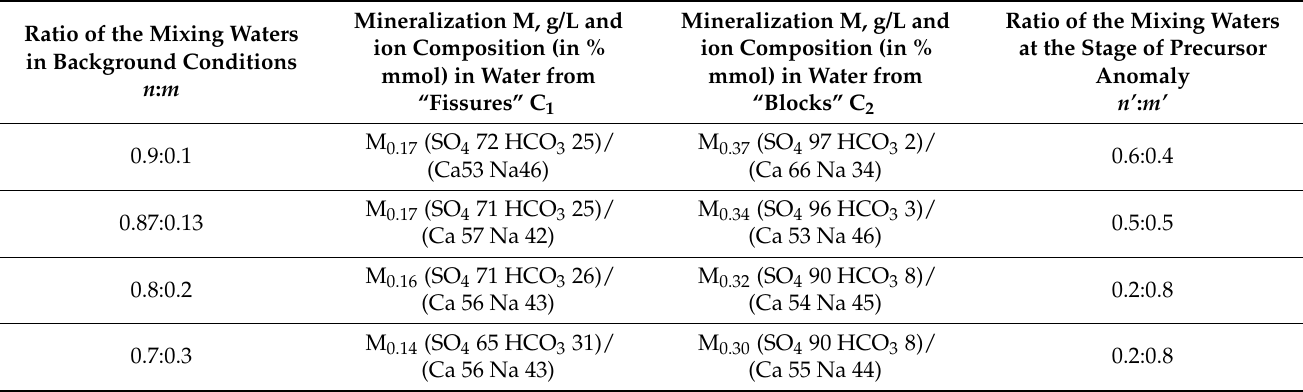
Table 3. Estimated mineralization (M, g/L) and ion composition in % mmol of two mixing waters C 1 and C 2 (see Figures 6a and 8b and text for